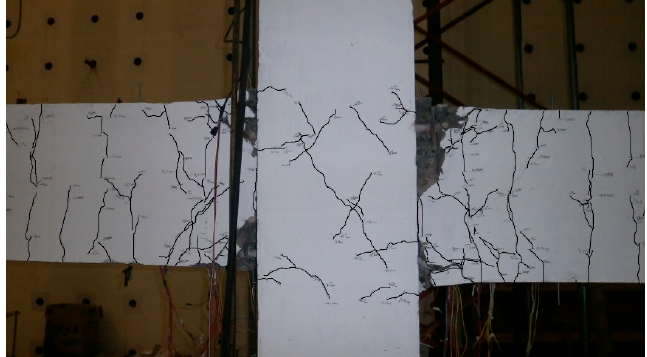
Figure 9. Final damage of cast-in-place joint.